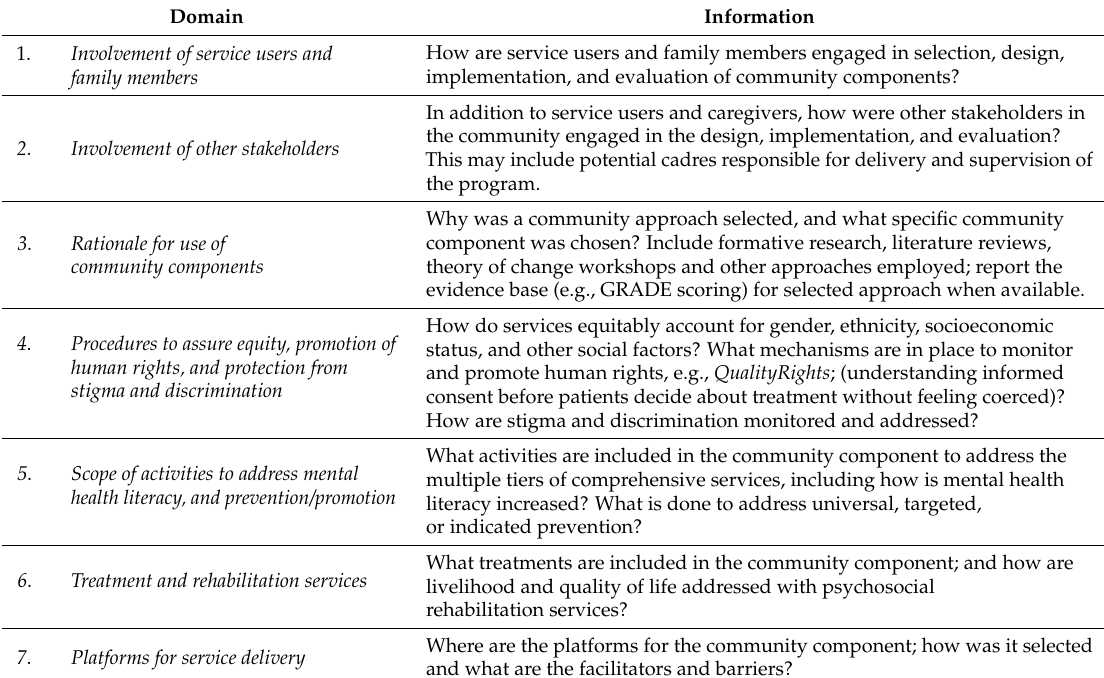
Table 3. Guidance for reporting of community mental health